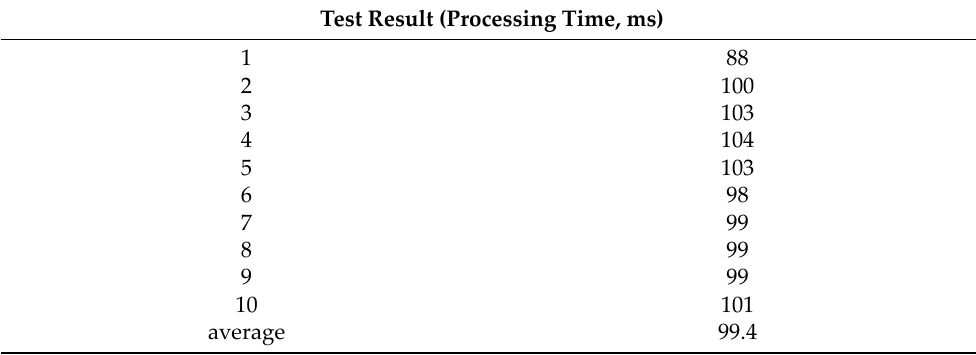
Table 6. Test results during ten times of repetition.